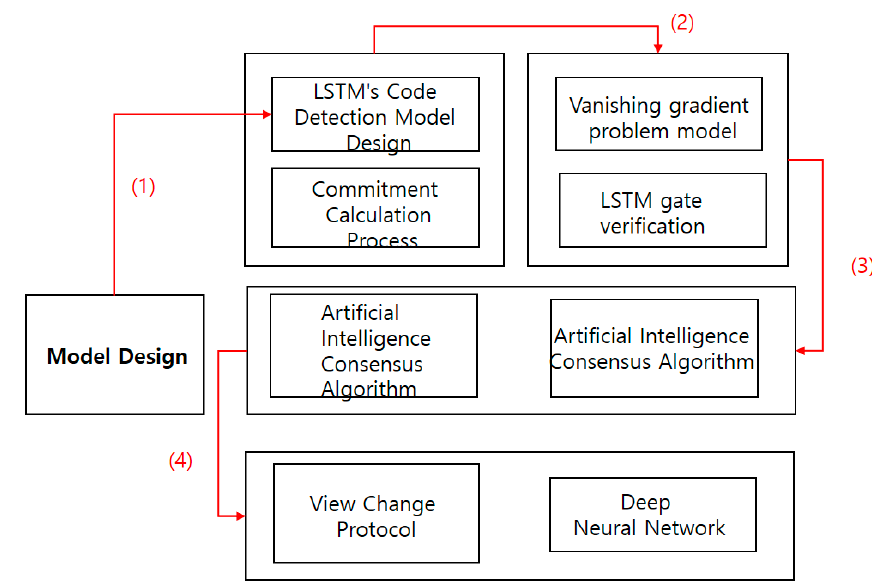
Figure 6. Research Figure 6. Research Methodology.